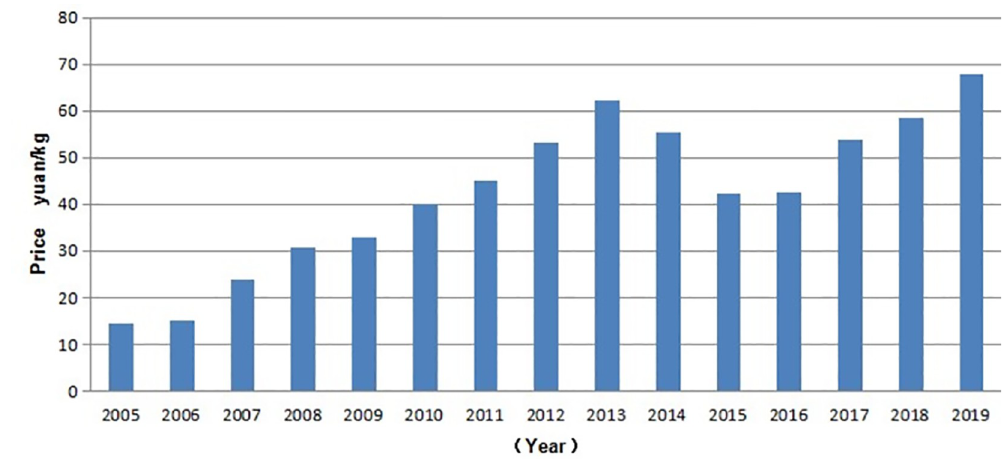
Fig 2. Xinjiang mutton price, 2003–2019 (yuan/kg). Note : The data source is arranged according to the Yearbook of China Animal Husbandry and Veterinary Medicine (2003–2017, market price in December each year). Due to the lack of animal products and feed prices in December 2003, the price of mutton in November 2003 was replaced.